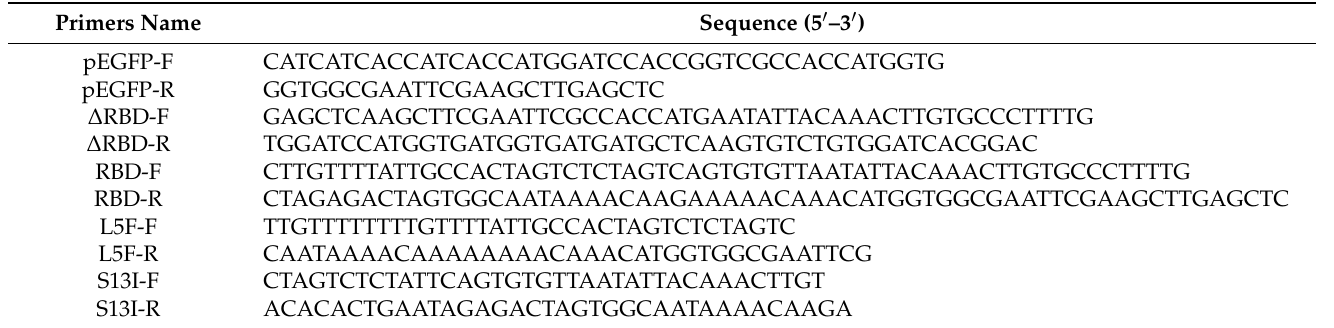
Table 1. Primers used in this